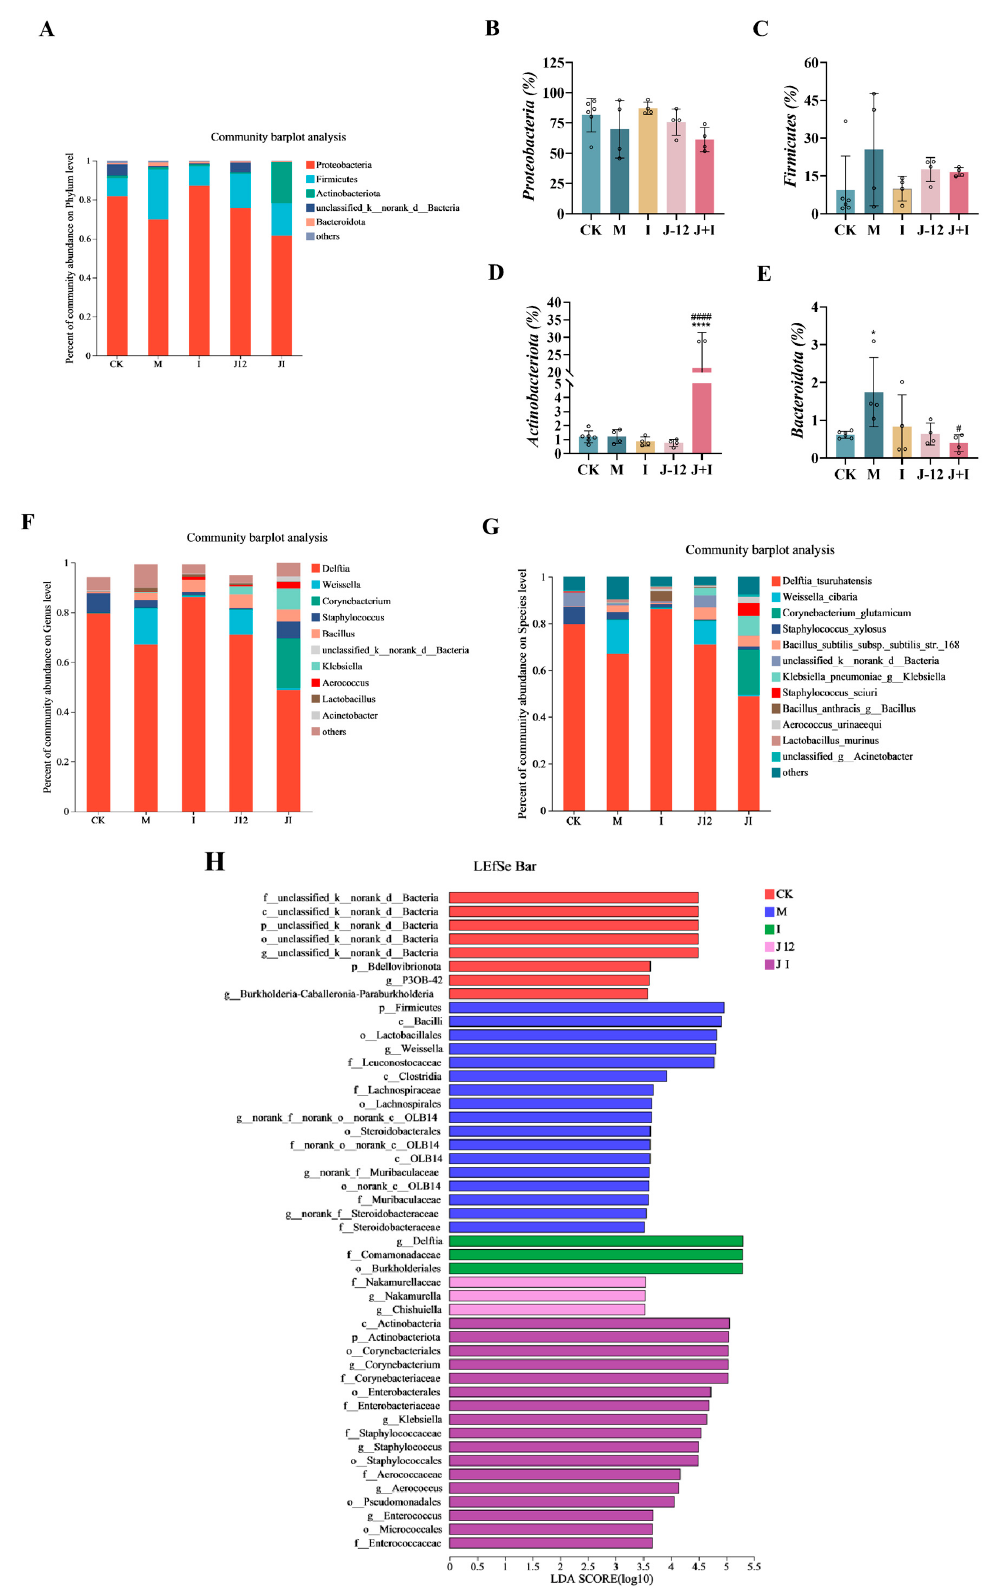
Figure 8. J-12 altered placental community diversity in rats with hyperglycemia in pregnancy. ( A ) Community structure of the placental microbiota at the phylum level. ( B – E ) Relative abundances of Proteobacteria, Firmicutes, Actinobacteriota, and Bacteroidota. Statistical analyses were performed by using a one-way ANOVA with Tukey’s multiple comparison test. Data are presented as the means ± SD; * p < 0.05 and **** p < 0.0001, compared with the CK group; # p < 0.05 and #### p < 0.0001, compared with the M group. ( F ) Community structure of the placental microbiota at the genus level. ( G ) Community structure of the placental microbiota at the species level. ( H ) Multilevel discrimina- tion map of species differences in LEfSe. CK: control group, rats fed a standard diet. M: model group, rats fed an HFD and administered a single STZ injection prior to pregnancy and then fed a standard diet during pregnancy. I: insulin group, rats fed an HFD and administered a single STZ injection prior to pregnancy and then fed a standard diet and injected with insulin during preg- nancy. J-12: J-12 group, rats fed an HFD and administered a single STZ injection prior to pregnancy and then fed a standard diet during pregnancy. Rats administered the J-12 suspension (1 × 10 9 CFU daily) by gavage during the entire experimental period. J + I: J-12 plus insulin group, rats fed an HFD and administered a single STZ injection prior to pregnancy and then fed a standard diet and injected with insulin during pregnancy. Rats administered the J-12 suspension (1 × 10 9 CFU daily) by gavage during the entire experimental period. The threshold of logarithmic LDA score is 3.5. 3.11. Predicted Metabolic Profile of the Placental Microbiome after J-12 Supplementation In view of the above structural changes, the 16S rRNA data were further analyzed by using PICRUSt to predict the metabolism of fecal microbiota in all groups. The Kyoto En- cyclopaedia of Genes and Genomes database (KEGG, http://www.genome.jp/kegg/ (ac- cessed on 16 December 2022)) was used for determining whether J-12 caused obvious changes in the functional pathways of the placental microbiota in rats with HIP. The J-12 could regulate metabolism and the genetic- and environmental-information- processing-related pathways (Figure 9). The metabolic pathways are involved in glucose- and lipid-metabolism-related pathways. Among these, glucose-metabolism-related path- ways, carbon metabolism, biosynthesis of amino acids, glyoxylate and dicarboxylate me- tabolism, pyruvate metabolism, and oxidative phosphorylation were characterized. The